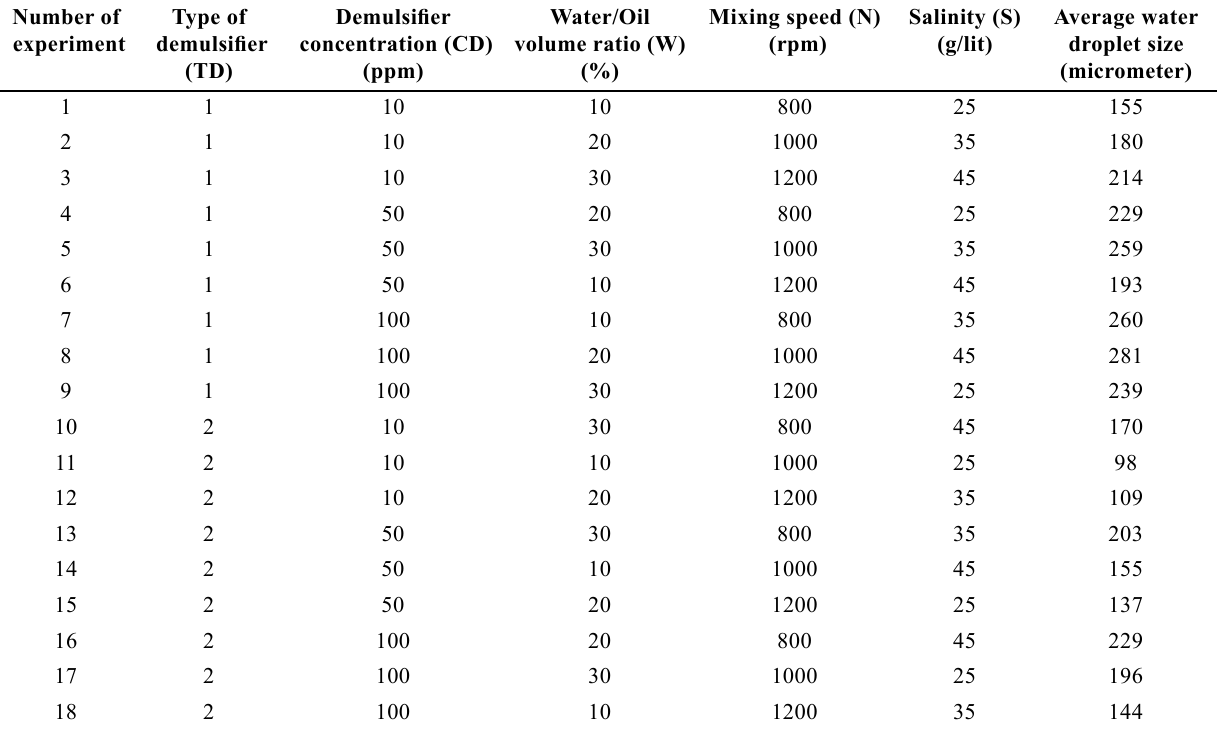
NMR Experimental results with design tests in Taguchi method at different levels. Number of